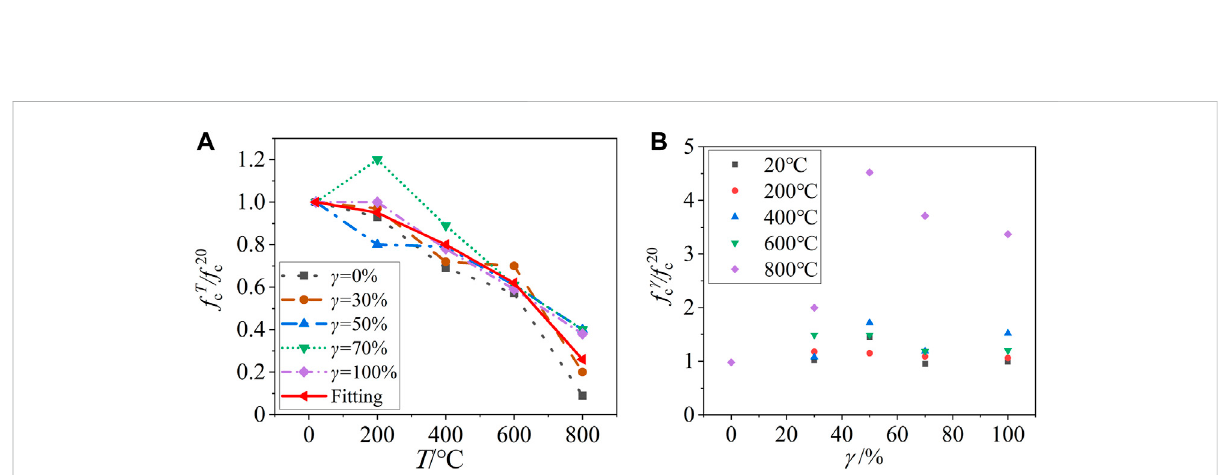
FIGURE 14 (A) Effect of temperature on strength of specimen; (B) Effect of replacement ratio on strength of specimens.